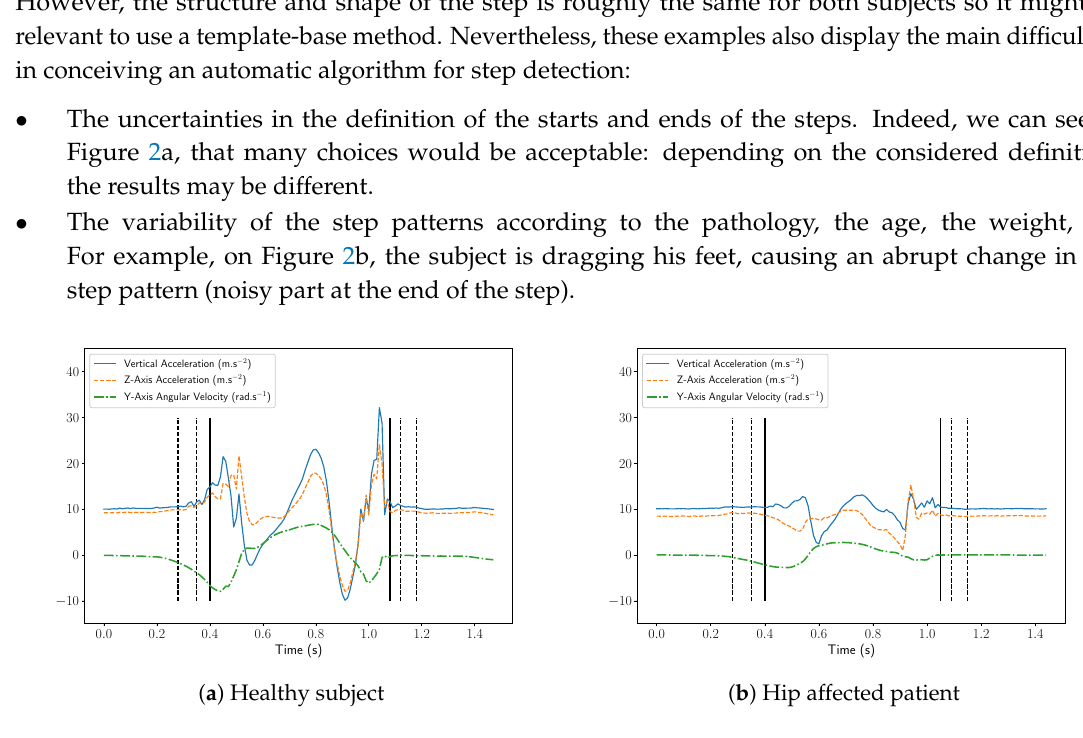
Figure 2. Vertical acceleration, Z-axis acceleration and the Y-axis angular velocity recorded from the right foot. The vertical dot lines display the different possibilities for start/end times and the plain lines display the choice made by the